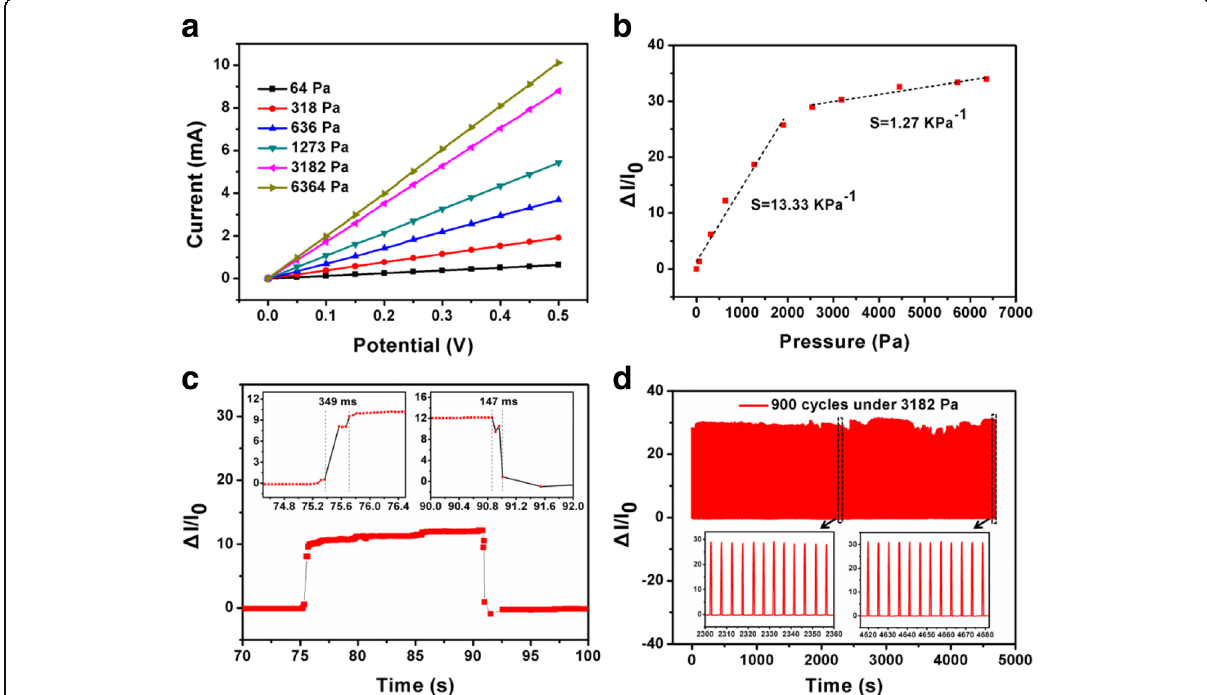
Fig. 4 Pressure sensing performances of the device. a Typical current – voltage curves of the sensor responding to different applied pressure. b Current changes of the sensor response to various applied pressure showing the pressure sensitivity value in a range of 64 – 1909 Pa is 13.33KPa − 1 and 1.27KPa − 1 in a range of 2545 – 6364Pa. c Instant response of the sensor towards applied pressure showing a response time of 349ms and relaxation time of 147ms under 636Pa. d Working stability of the sensor for 900cycles under a pressure of 3182Pa and the magnified view of the middle and last